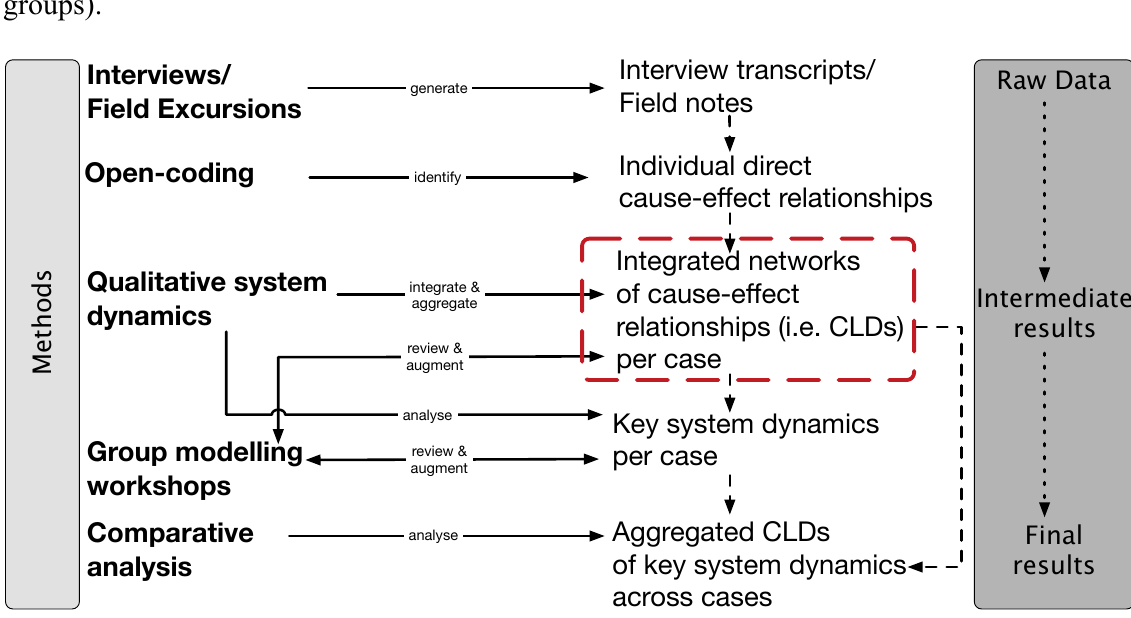
Figure 3 (from main paper). The CLDs in this appendix describe intermediate results, i.e. integrated networks of cause-effect relationships per case, prior to analysis of key system dynamics and across case